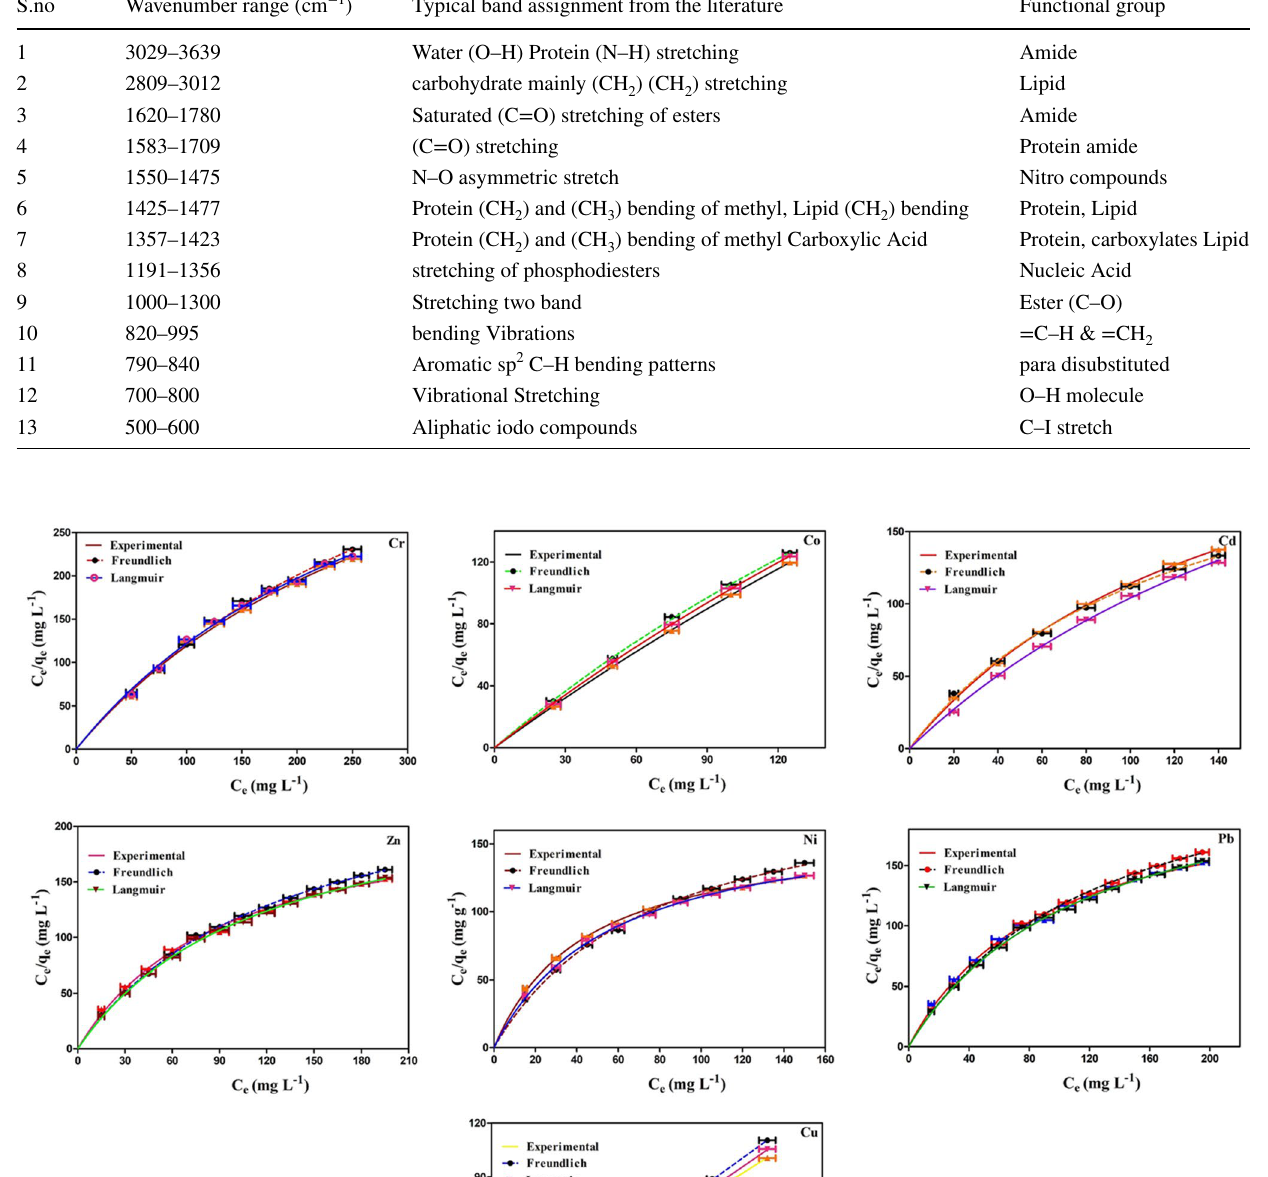
Table 6 Characteristics FTIR absorption wavenumbers